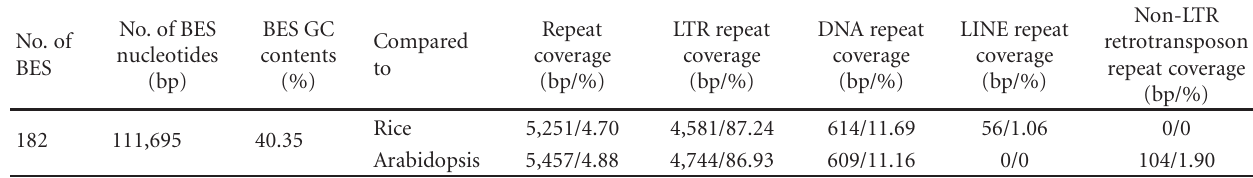
Table 2: Analysis of repetitive elements from preliminary BAC-end sequence (BES) of the Camellia sinensis tea BAC library, CSBCBa. No. of BES